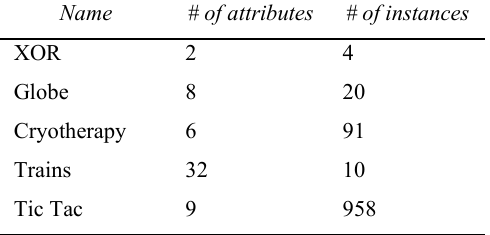
Table 1. Summary of the binary classification